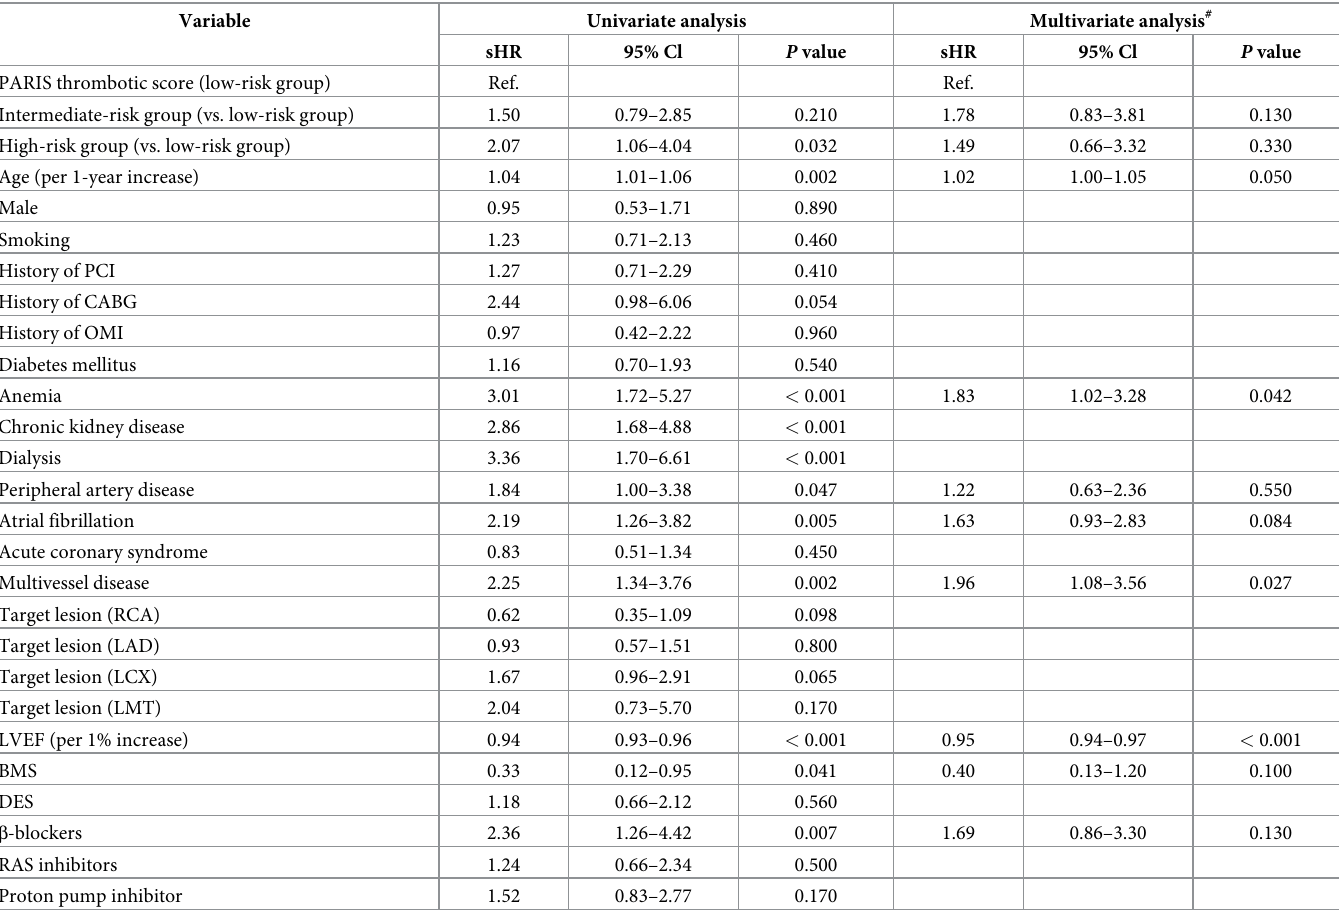
Table 6. Fine and Gray model (subdistribution hazard model) for cardiac